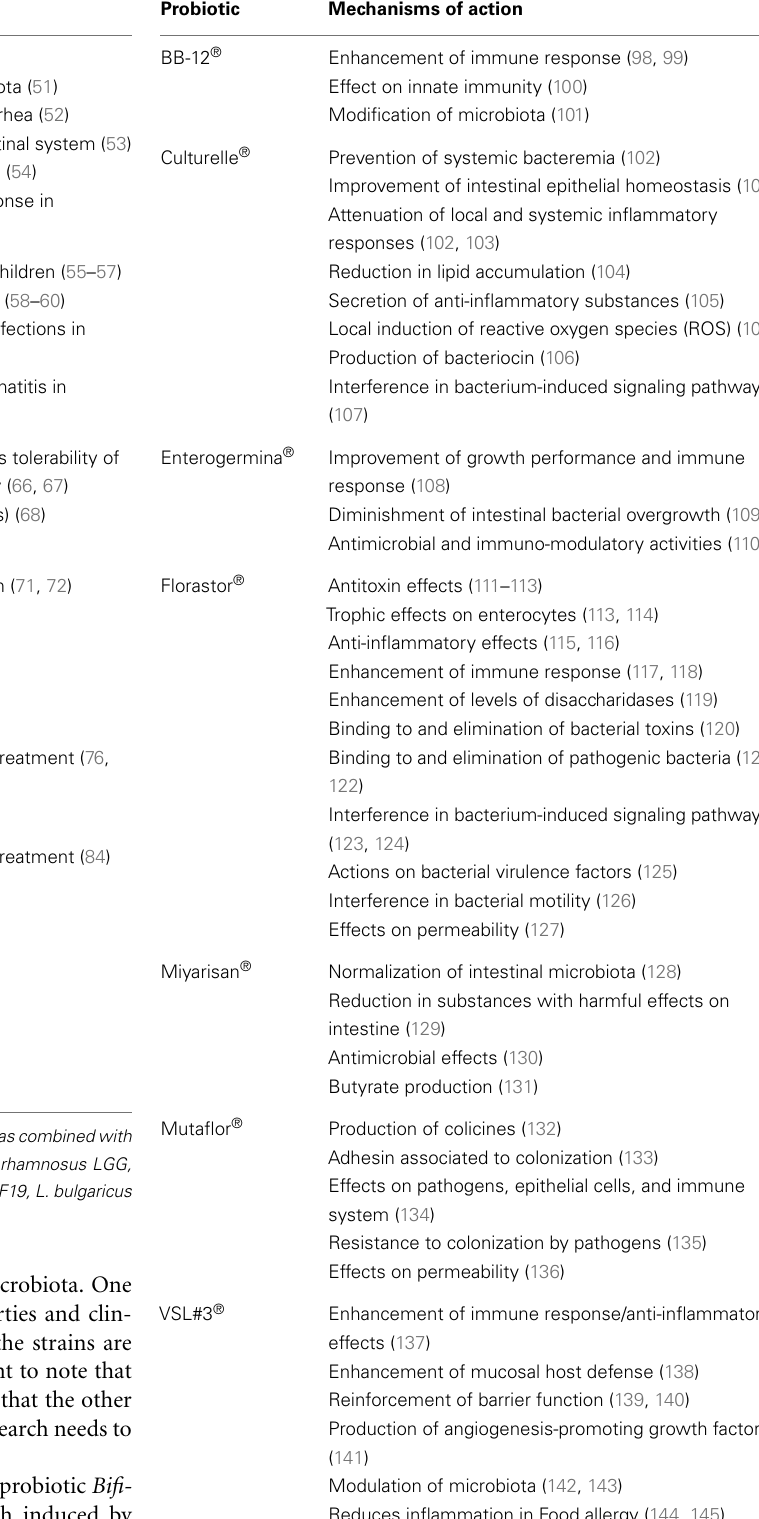
Table 2 | Main medical/clinical benefits of the major pharmaceutical probiotic products for human purposes.